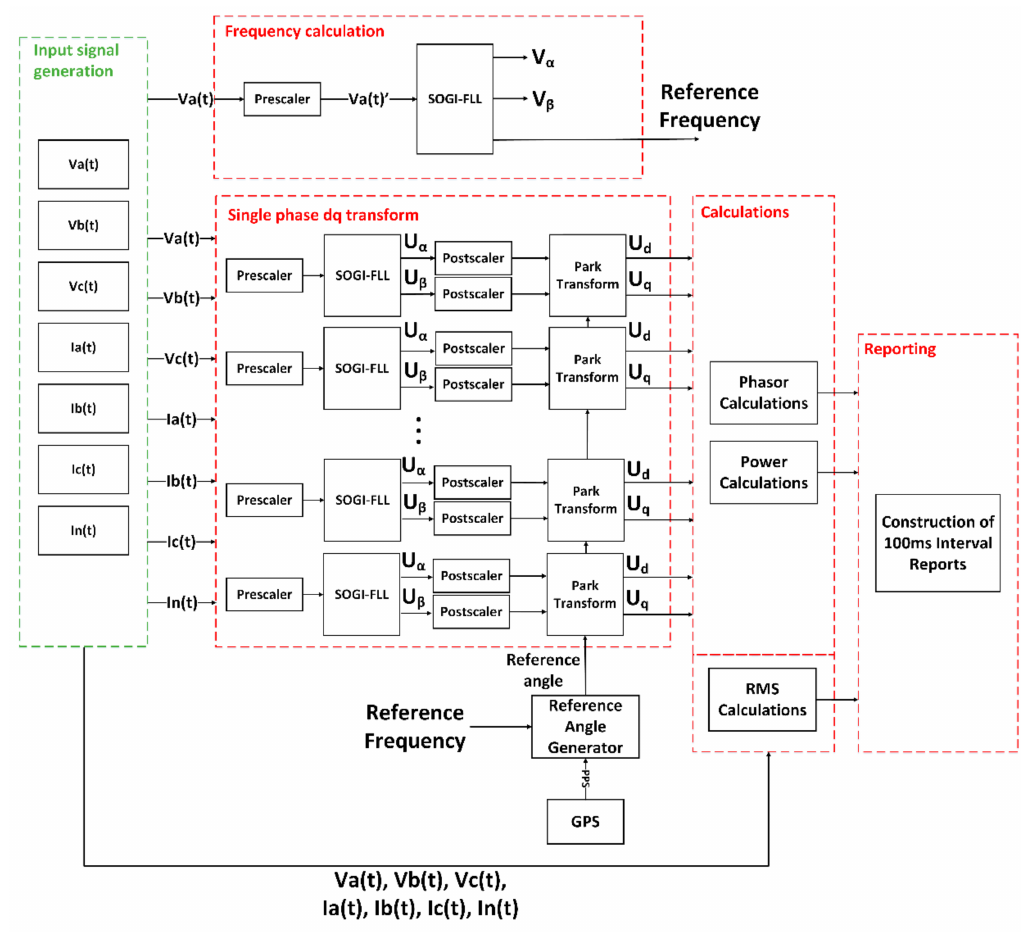
Figure 6. Block scheme of the phasor, frequency, power, and RMS calculation